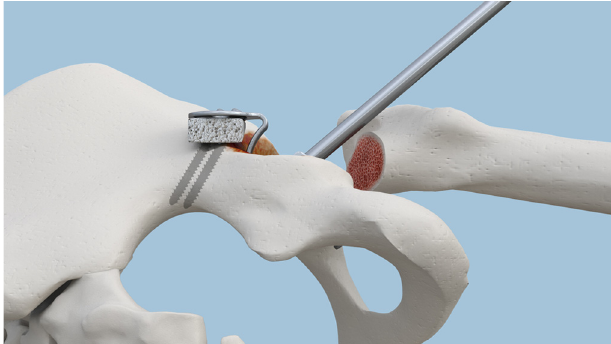
Figure 3. Inclination of 45 degrees of the plate.